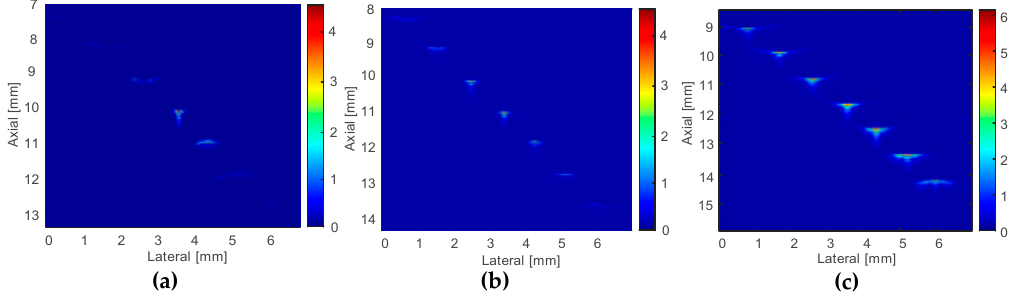
Figure 10. C-scan images of the wire phantom of ( a ) single-focal point transducer T 1 , ( b ) multifocal point transducer with three focal points T 2 , and ( c ) multifocal point transducer with five focal points T 3 .